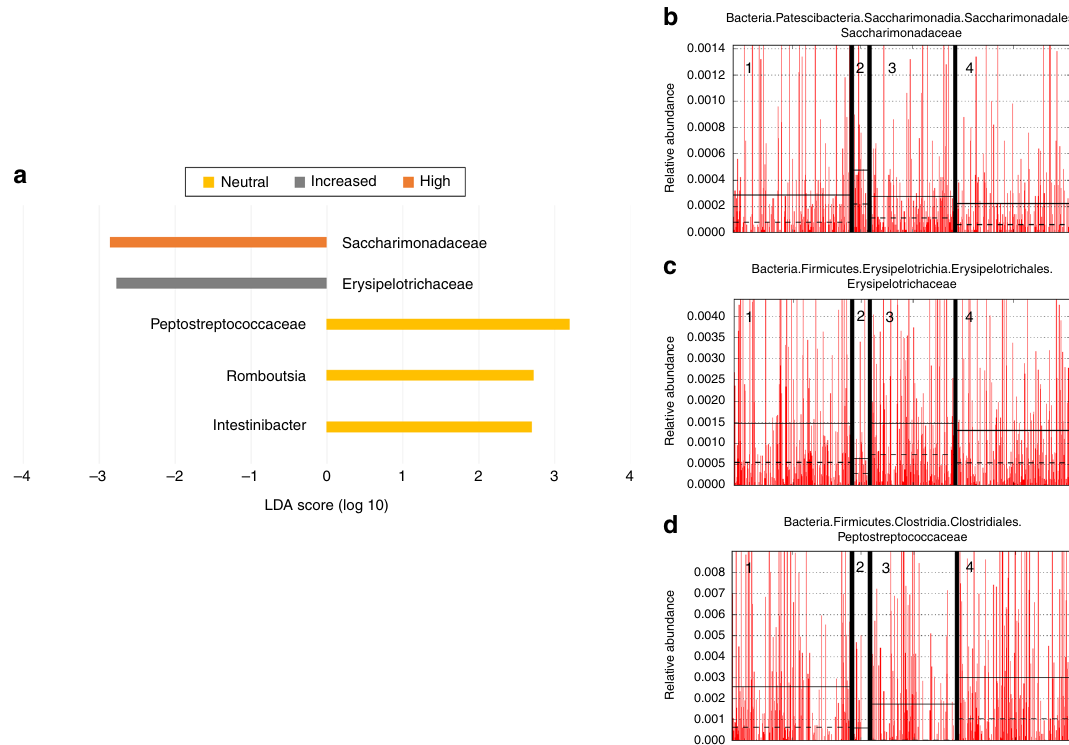
Fig. 2 Speci fi c taxa are associated with genetic risk. a LEfSe biomarker discovery results for the entire dataset ( n = 403 individual stool samples). Signi fi cant taxa are displayed according to their associated risk group and their differential log 10 LDA score. b – d Differential features identi fi ed by LEfSe have higher average relative abundance with their associated risk group. b Saccharimonadaceae, c Erysipelotrichaceae, d Peptostreptococceae, (1) Decreased risk, (2) High risk, (3) Increased risk, (4) Neutral risk. Breastfeeding status at the time of sample collection was corrected for in the LEfSe model design. Source data are provided in the source data fi